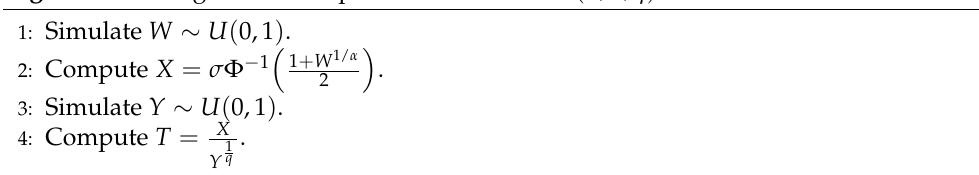
Algorithm 1: for generate samples from T